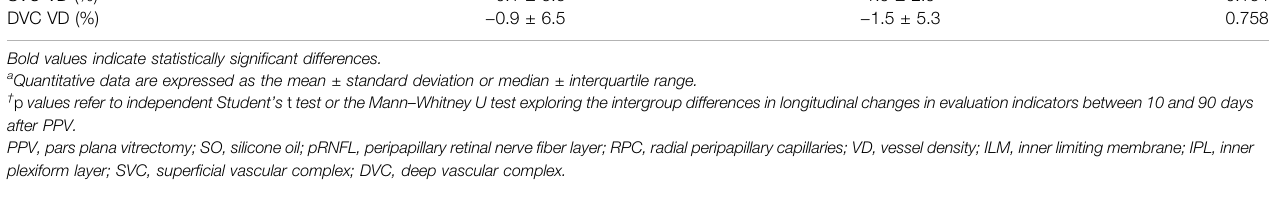
TABLE4| CorrelationsbetweenchangesinpRNFLthicknessandothervariables.